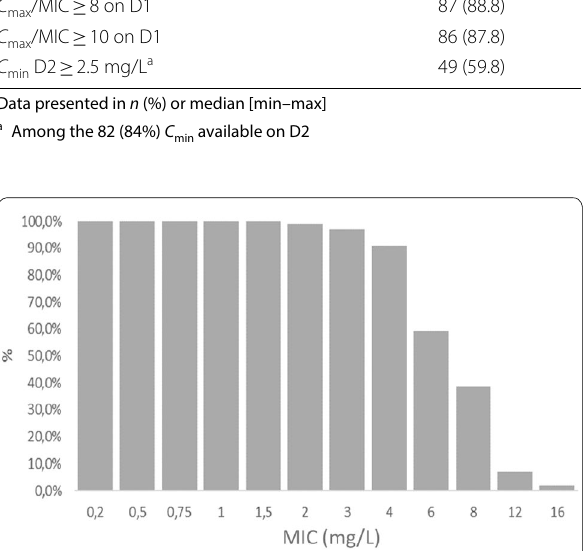
Fig. 2 Probability of achieving target C max /MIC ratio the